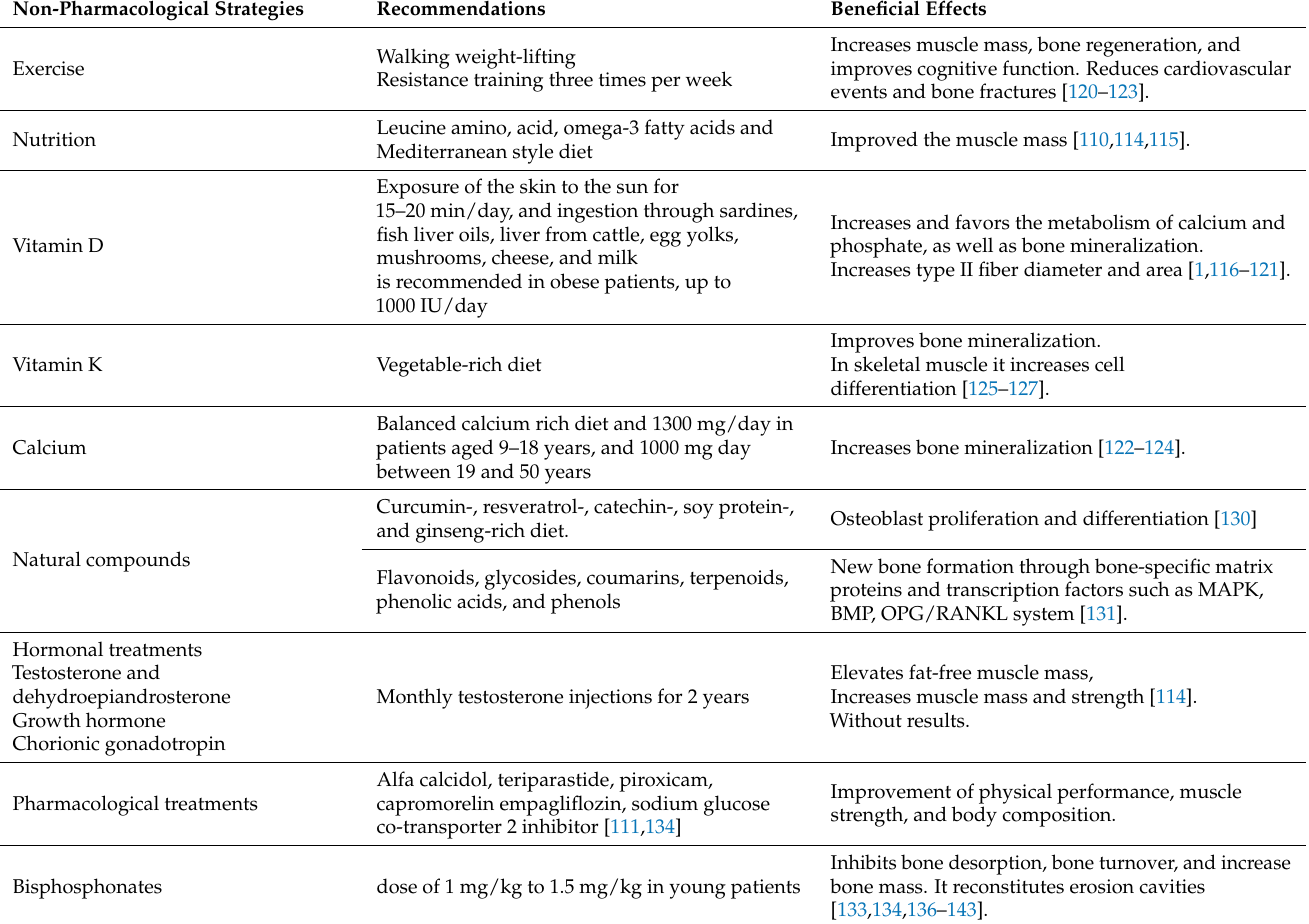
Table 1. Summary of the possible treatments to combat